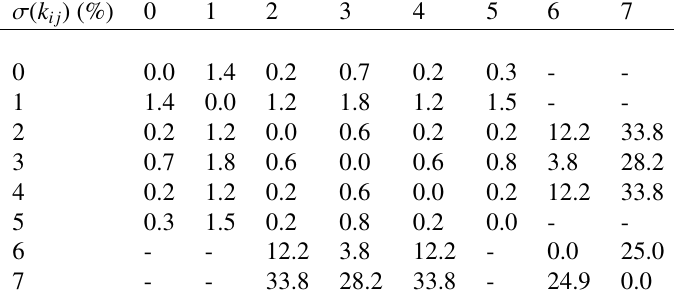
Table 2. Relative standard deviations of normalization factor k ij between all